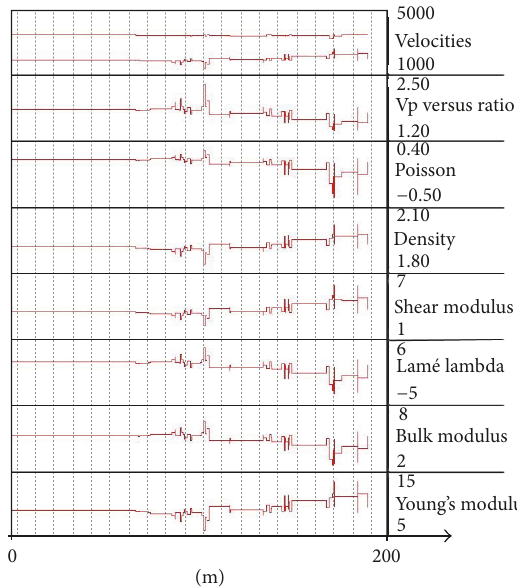
Figure 1: Rock mechanics parameters of the geological forecast.